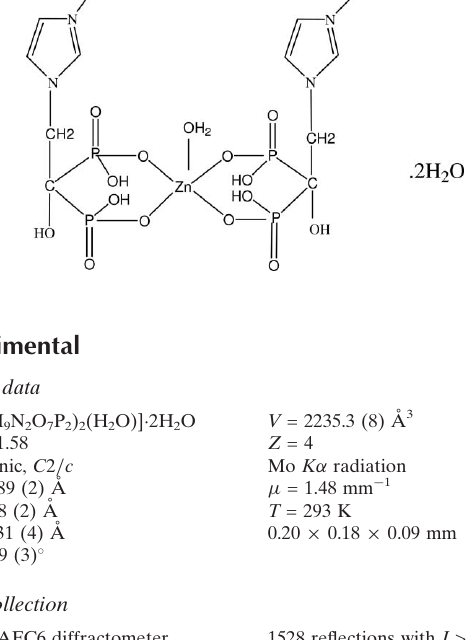
Data collection